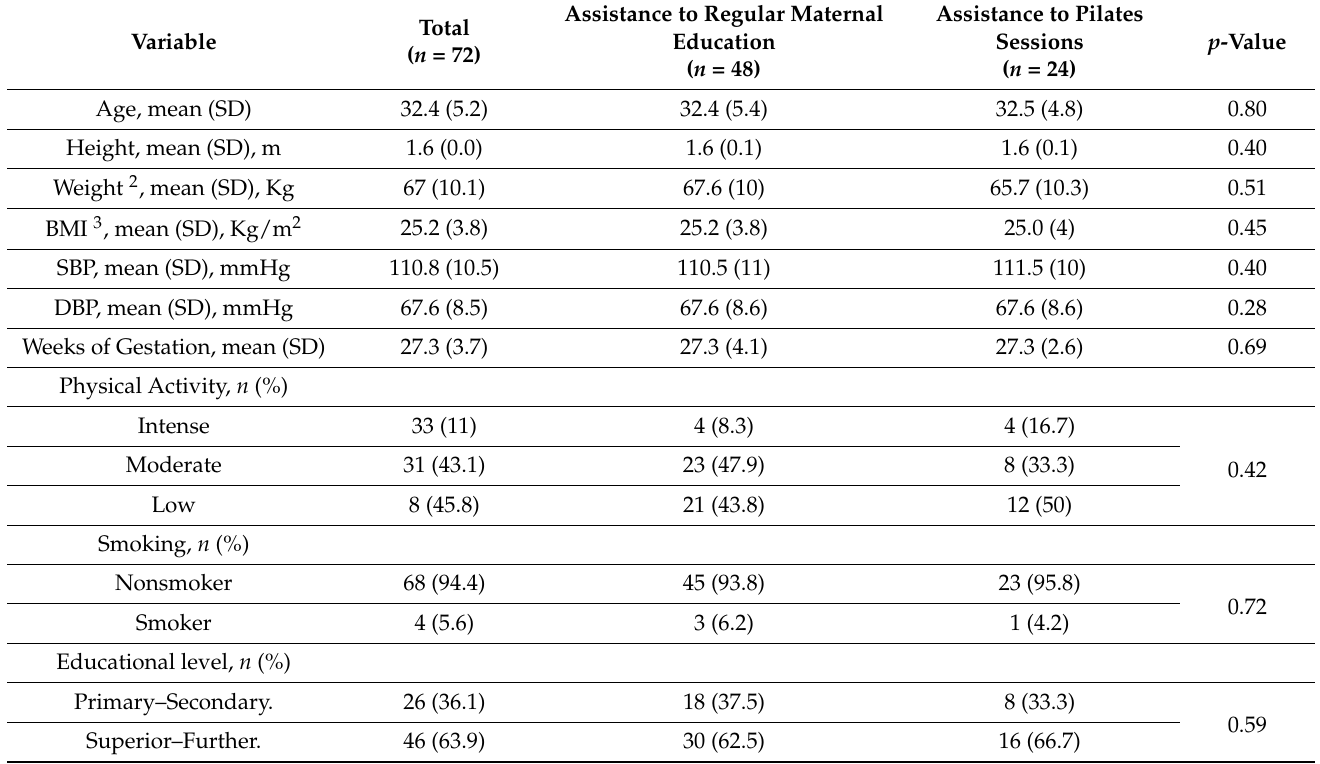
Table 2. Demographic characteristics of 72 pregnant women who received prenatal care 1 .